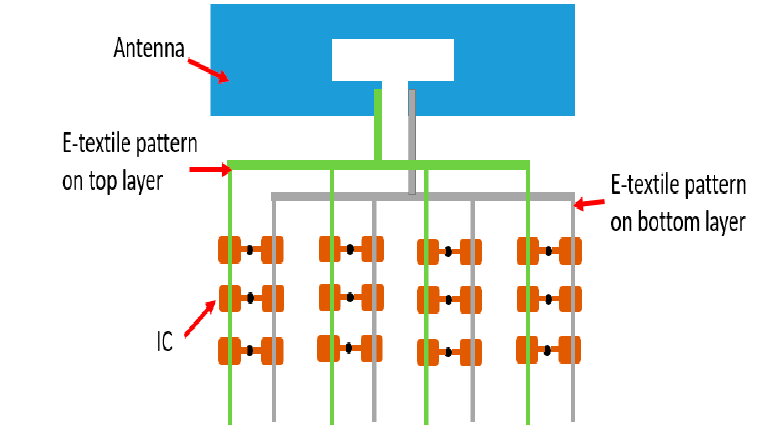
Figure 2. Illustration of the platform design.